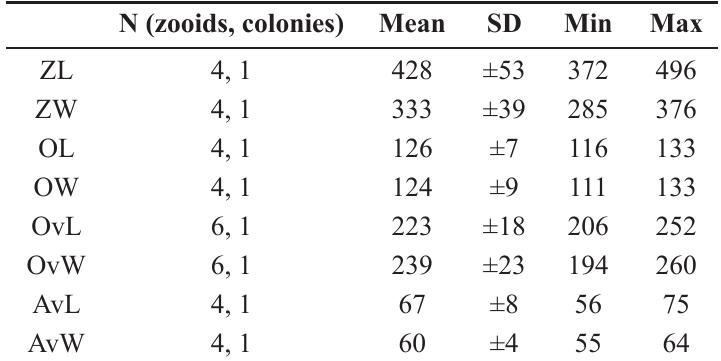
Table 2. Measurements in microns of Parkermavella columnaris sp. nov., Recent, New Zealand (inferred greater Cook Strait).